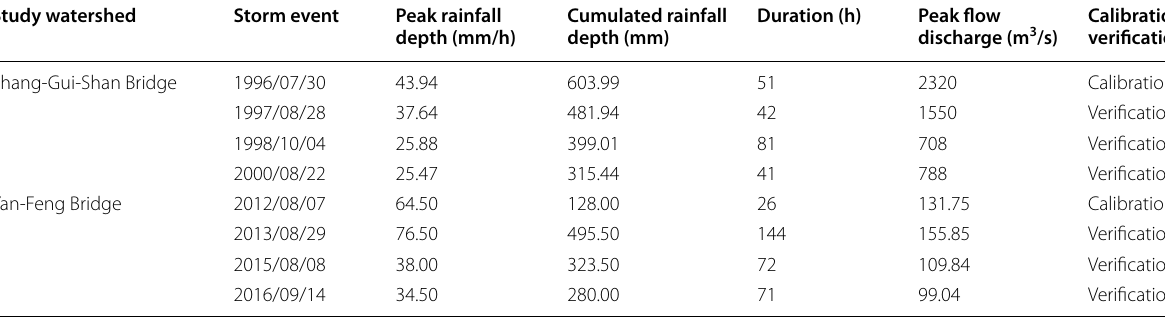
Table 2 Rainstorm events for runoff simulation in the study area Study watershed Storm